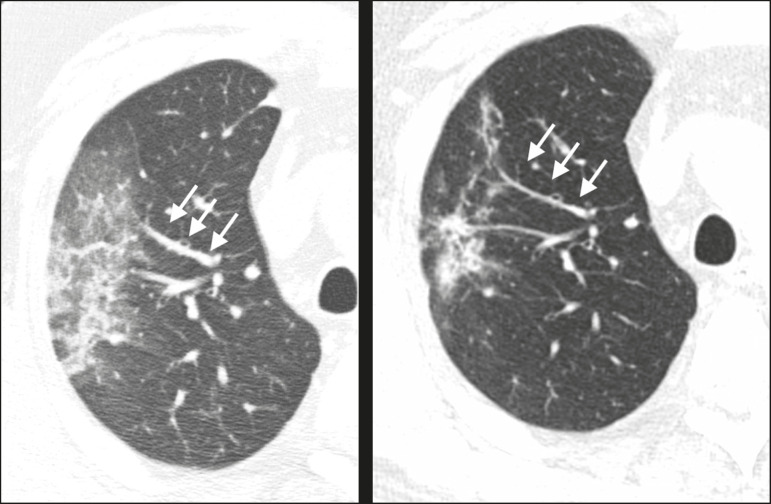
A 64-year-old male patient. A: CT scan acquired on day 3 after symptom onset. Note the increased vessel caliber in the parenchyma of the right upper lobe (arrows), adjacent to an area with the crazy-paving pattern. B: CT scan, acquired 28 days after the first CT, showing reduced vessel caliber and resolution of the crazy-paving pattern, with small residual consolidation.